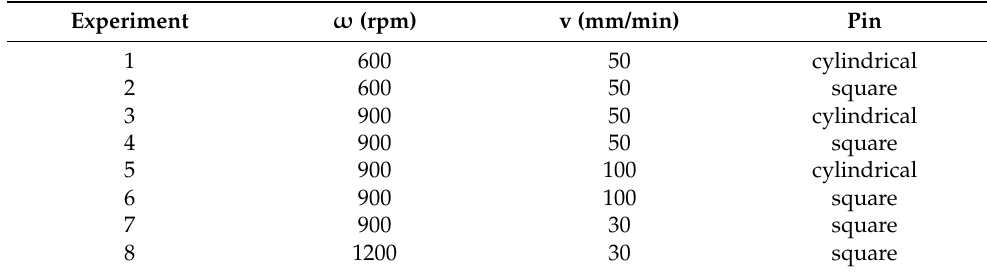
Table 1. Friction stir processing (FSP) list of